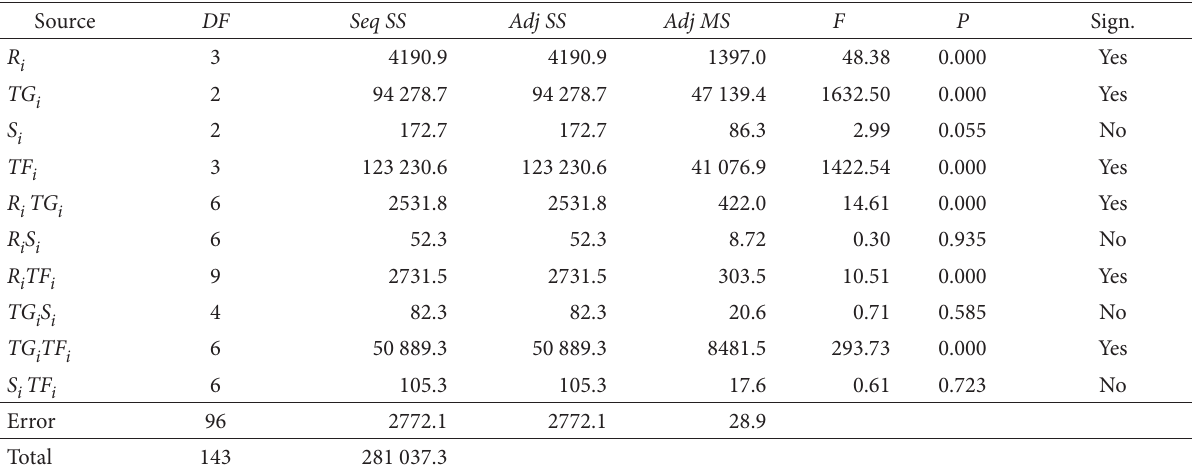
Table 3. Anova for stop-line delays in R -scenarios Source